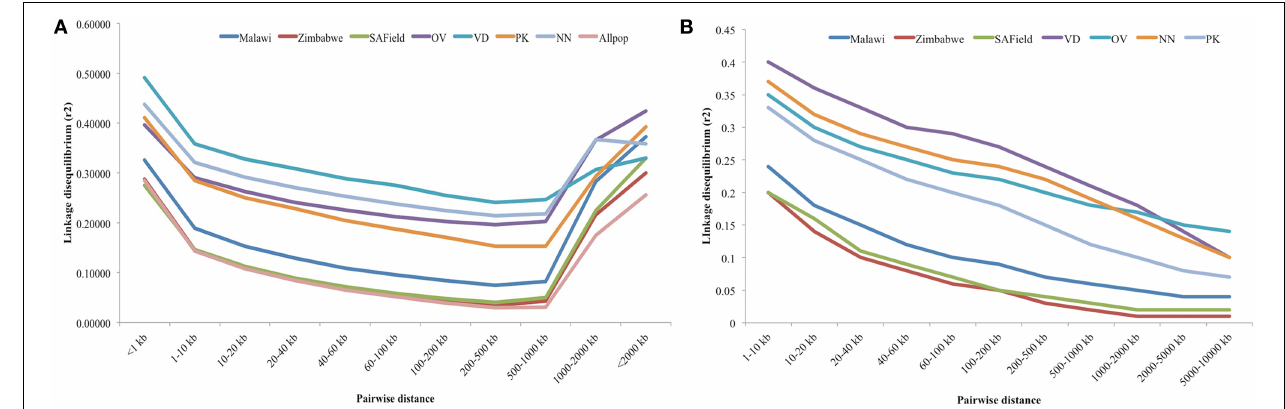
FIGURE 4 | (A) Average LD decay with increased physical distance between SNPs for chromosomes 1–28. VD, Venda conservation flocks; NN, Naked Neck conservation flocks; OV, Ovambo conservation flocks; PK, Potchefstroom Koekoek conservation flock; SAField, village chickens from South Africa; Zimbabwe, village chickens from Zimbabwe; Malawi, village chickens from Malawi. (B) Average LD